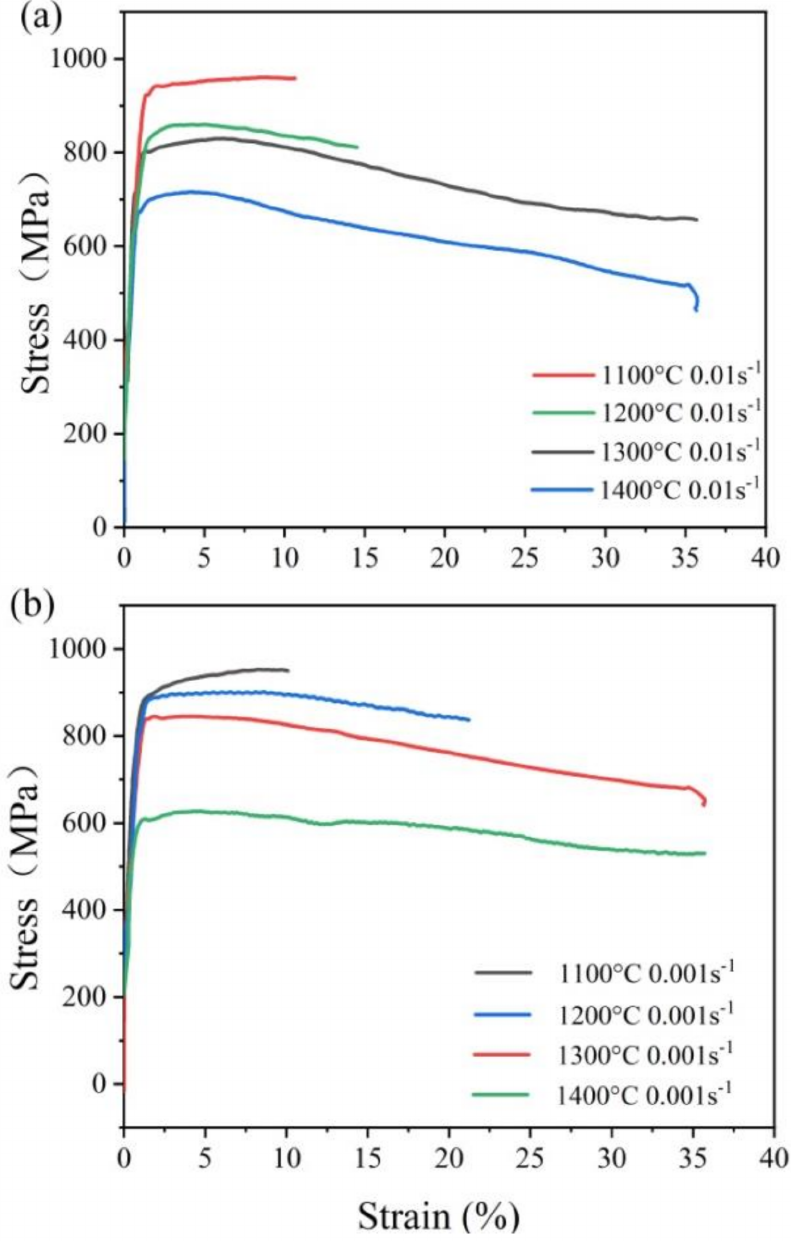
Figure 5. Stress–strain curves of [021] oriented Mo5SiB2 single crystals after deformation at different temperatures at the stain rates of ( a ) 0.01 s − 1 and ( b ) 0.001 s − 1